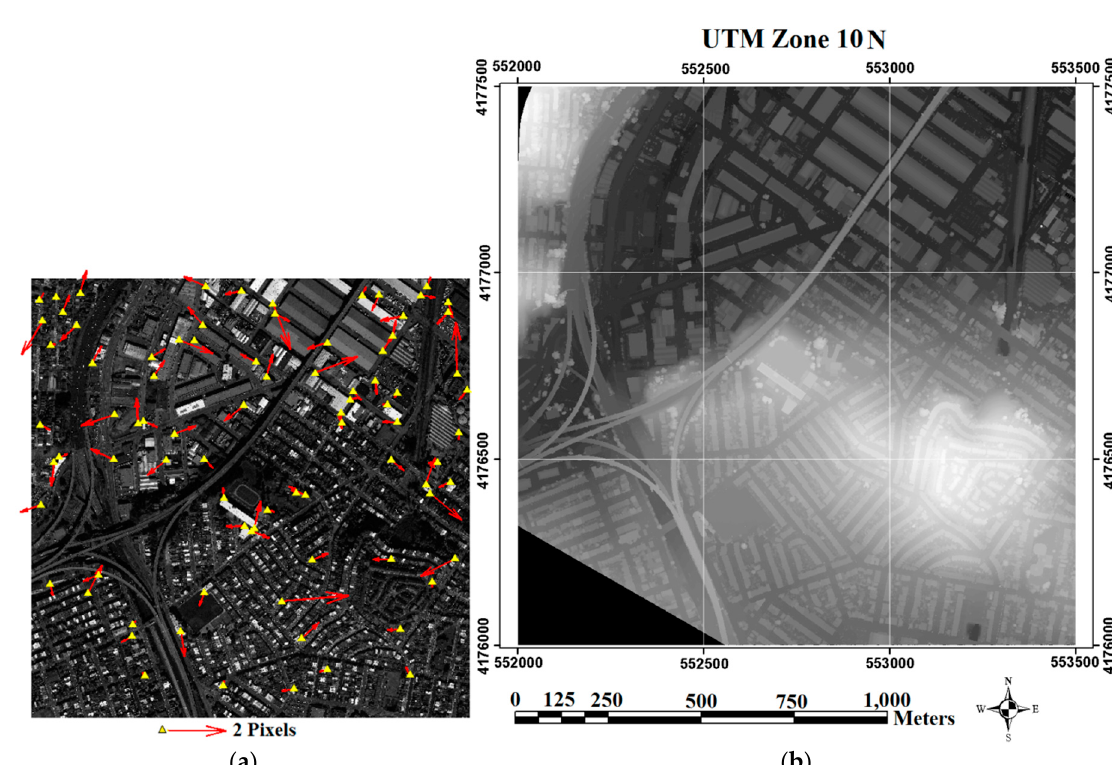
Figure 3. A view of the sample dataset: ( a ) QB panchromatic image from the sample dataset; ( b ) Raster LiDAR data from the sample dataset.